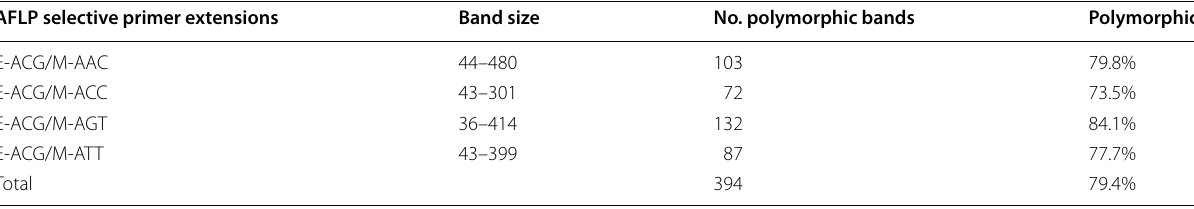
Table 1 Restriction enzyme primer combinations from Amplified Fragment Polymorphism AFLP selective primer extensions